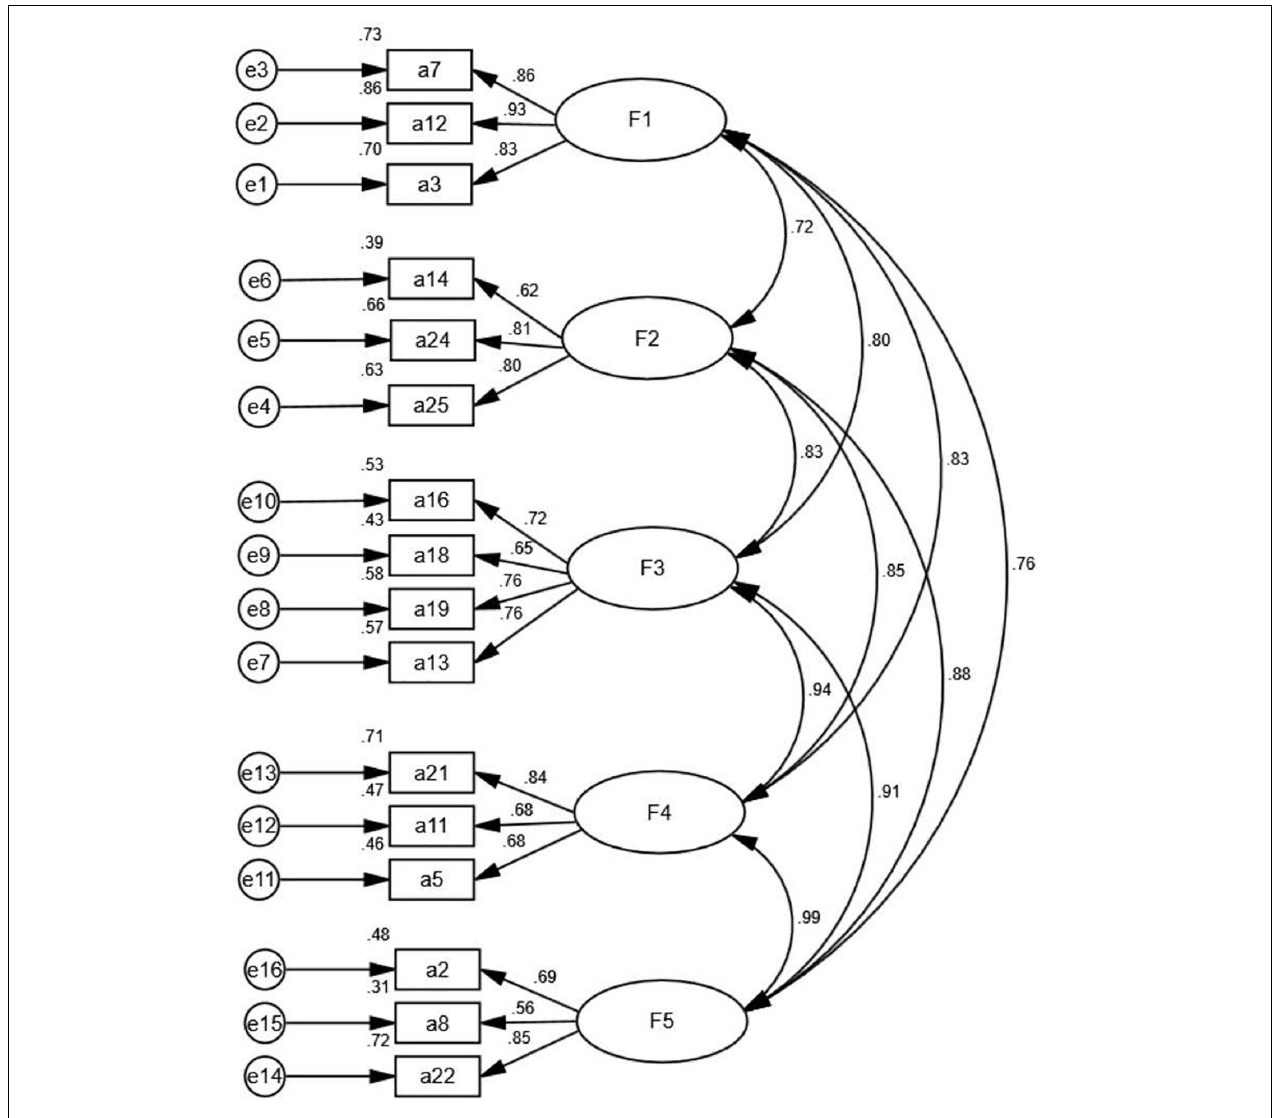
FIGURE 1 | The first-order CFA model of win-win.